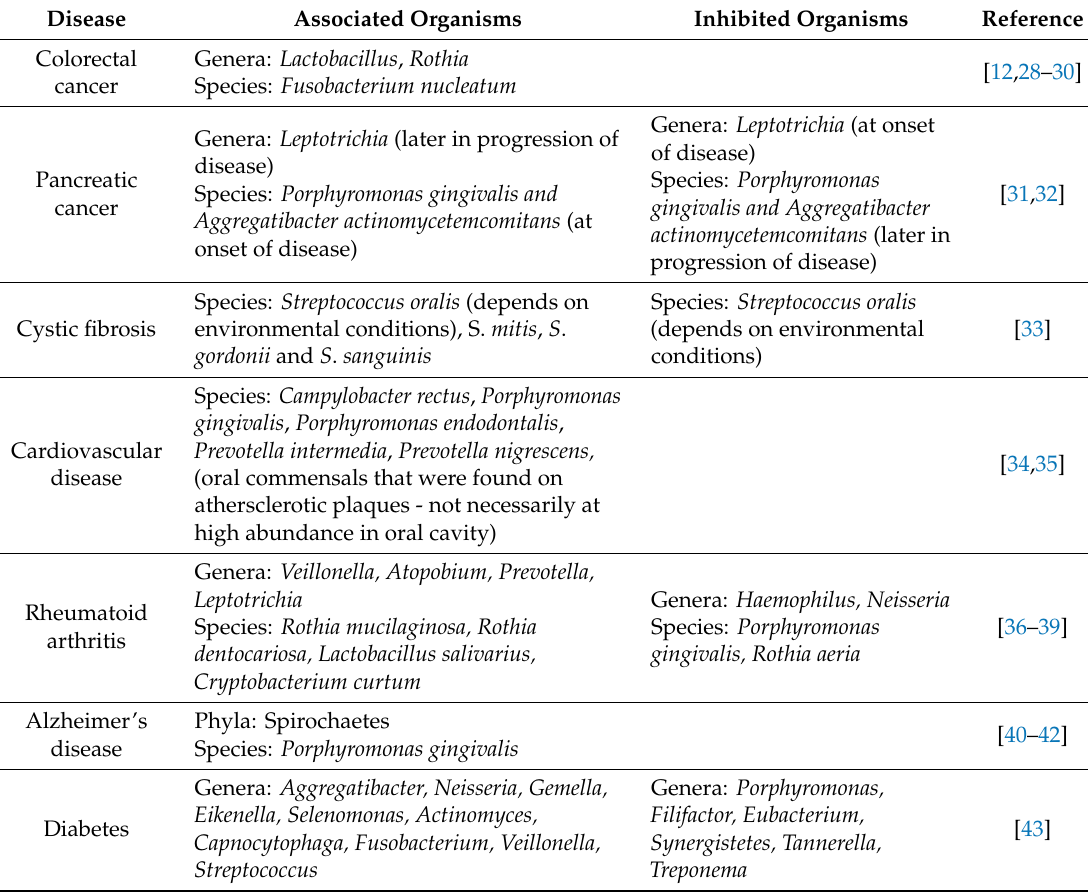
Table 2. Examples of metagenomic studies of associations between the oral microbiome and systemic diseases. The first column indicates a disease, the second indicates organisms that have been found at higher abundances in individuals presenting with the disease, the third indicates organisms at lower abundances, and the fourth contains the references to literature which displays these